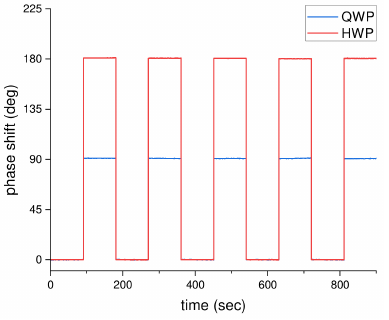
Figure 2. The phase shift of the QWP and HWP measured by the proposed simple phase-sensitive SPR